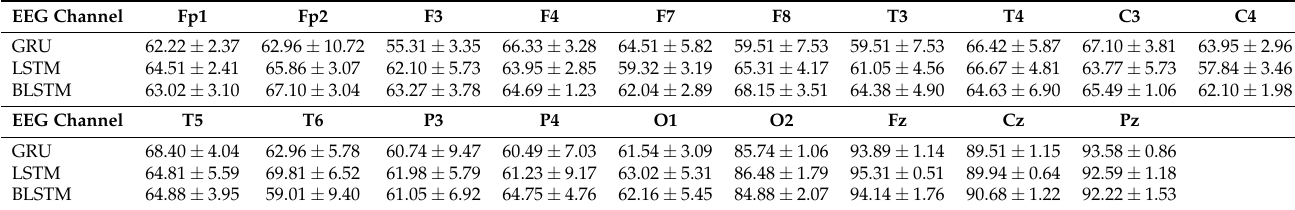
Table 8. Summary of the performance (%) obtained using each EEG channel and RNN-based classifiers for the automated classification of the BMAC vs. GMAC